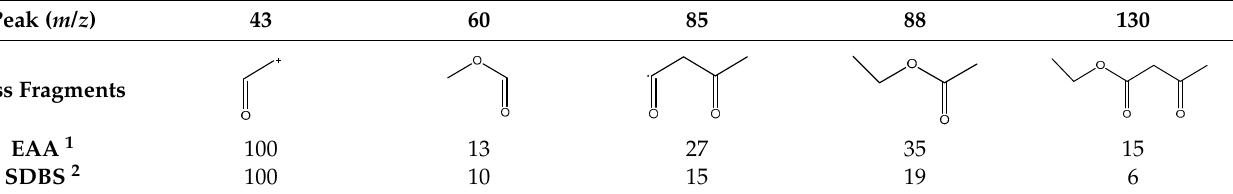
Figure 2. Chromatograms of EAA and spectra of the 1 min peaks. Panel A to C, chromatograms for EAA unheated (Panel ( A )), EAA heated to 73.9 °C (Panel ( B )), and EAA heated to 93.3 °C (Panel ( C )). The x -axis is retention time in min. Panels ( D – F ), spectra of the 1 min peaks from the respective GC. The x -axis is m/z . The EAA molecule integrated in Panel ( A ) was taken from PubChem (https://pubchem.ncbi.nlm.nih.gov/compound/). A quantitative analysis was performed on the GC–MS data to compare the amount of EAA in the 1 min peaks. The area of the peak was determined by integrations from four replicate experiments and was used to calculate EAA concentration as µmol mL − 1 with the help of a calibration curve. Averages and standard deviations were 97 µmol mL − 1 ± 4.34% for the unheated sample, 93 µmol mL − 1 ± 7.75% for the 73.9 °C sample, and 91 µmol mL − 1 ± 2.15 for the 93.3 °C sample. The difference in EAA concentration between the unheated and the 73.9 °C sample is a decrease of 4%, which is less than the standard deviations for each of these samples. The difference in EAA concentration between the unheated and the